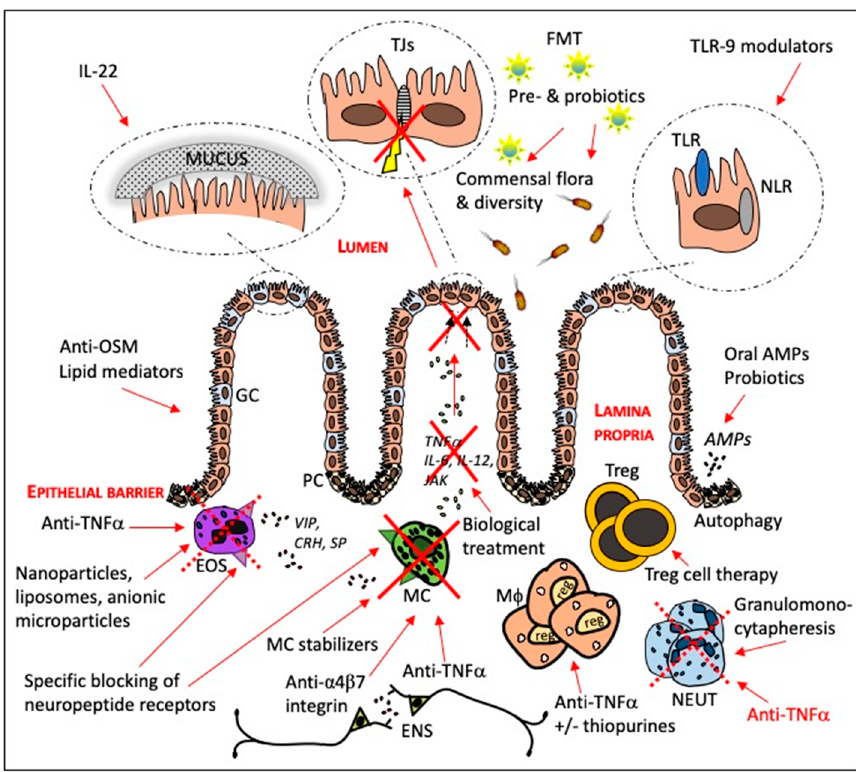
Figure 2. Current and potential therapies directed against targets to reduce inflammation and improve intestinal barrier function in patients with inflammatory bowel disease. AMPs = antimicrobial peptides, CRH = corticotrophin releasing hormone, ENS = enteric nervous system, EOS = eosinophil, FMT = fecal microbiota transplantation, GC = goblet cell, JAK = Janus kinases, M φ = macrophage MC = mast cell, NEUT = neutrophil NLR = nod-like receptor, OSM = oncostatin M, PC = Paneth cell, SP = substance P, TJs = tight junctions, TLR = toll-like receptor, Treg = regulatory T cell, VIP = vasoactive intestinal polypeptide.